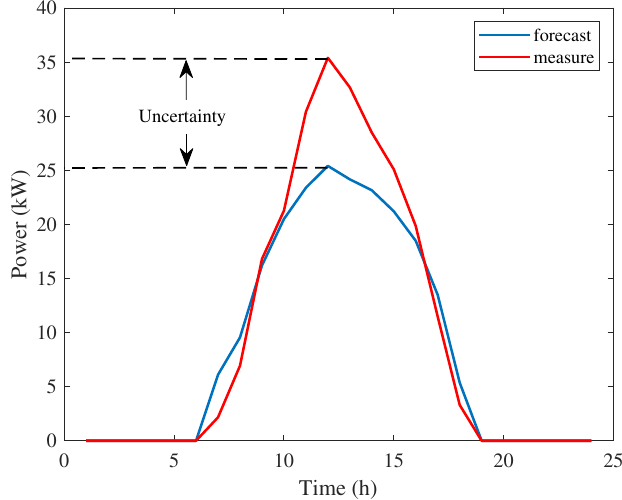
Figure 4. Forecast and actual PV power data.